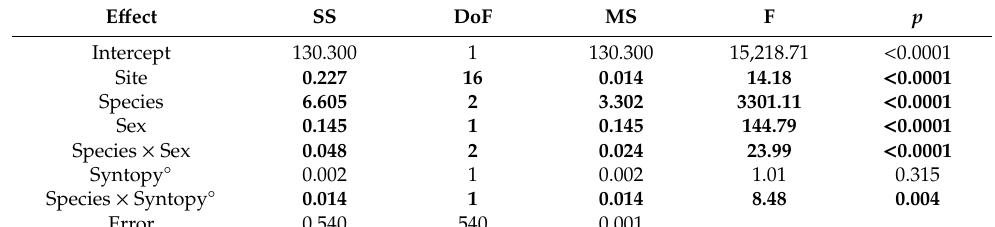
Table 1. Effect of site (random factor), species, sex, syntopy condition (yes/no), and interaction terms of fixed factors on newt body size (snout-vent length to the nearest mm; SVL) at the study sites. The effect of syntopy condition (°) was tested on Lissotriton italicus and Triturus carnifex only, because Lissotriton vulgaris was always found in co-occurrence with other species. Abbreviations: SS = sum of squares; MS = mean squares. Significant effects are highlighted in bold.